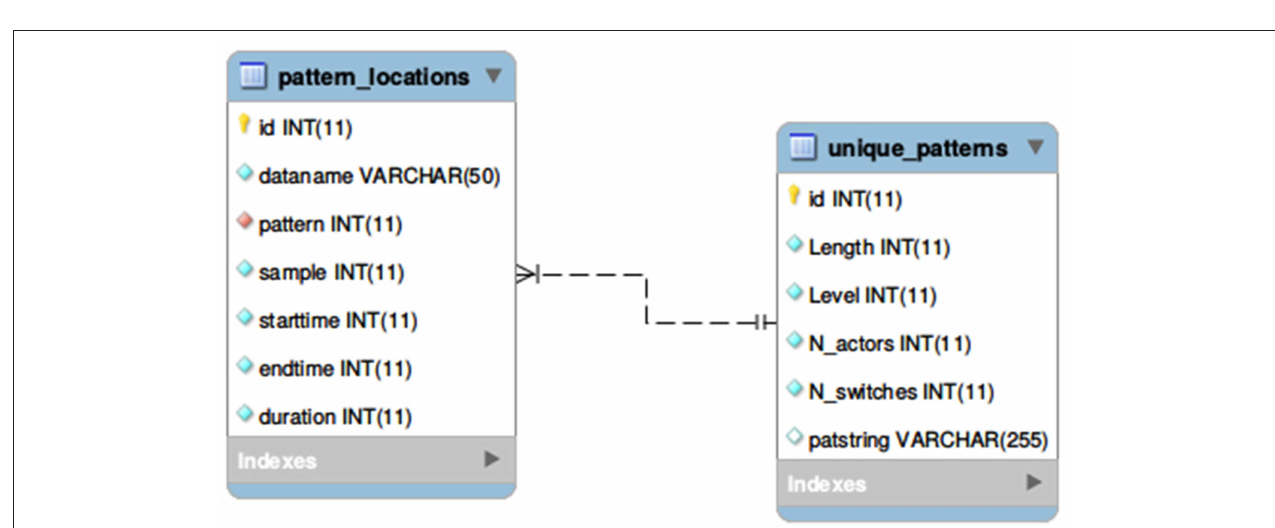
FIGURE 5 | The original (Left) and the resulting global scope (Right) of T-pattern identification.